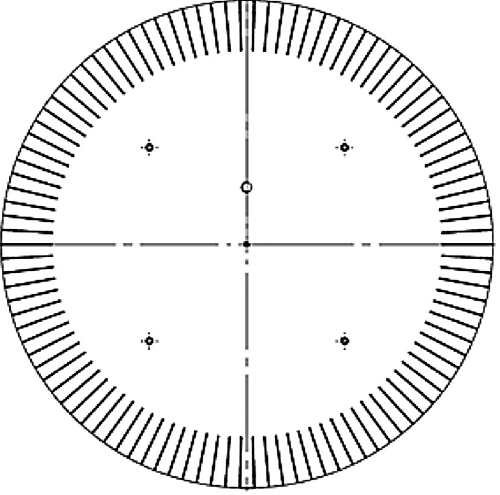
FIG. 12. The top view of the contact plate showing 107 slots in the equator area for sufficient electrical